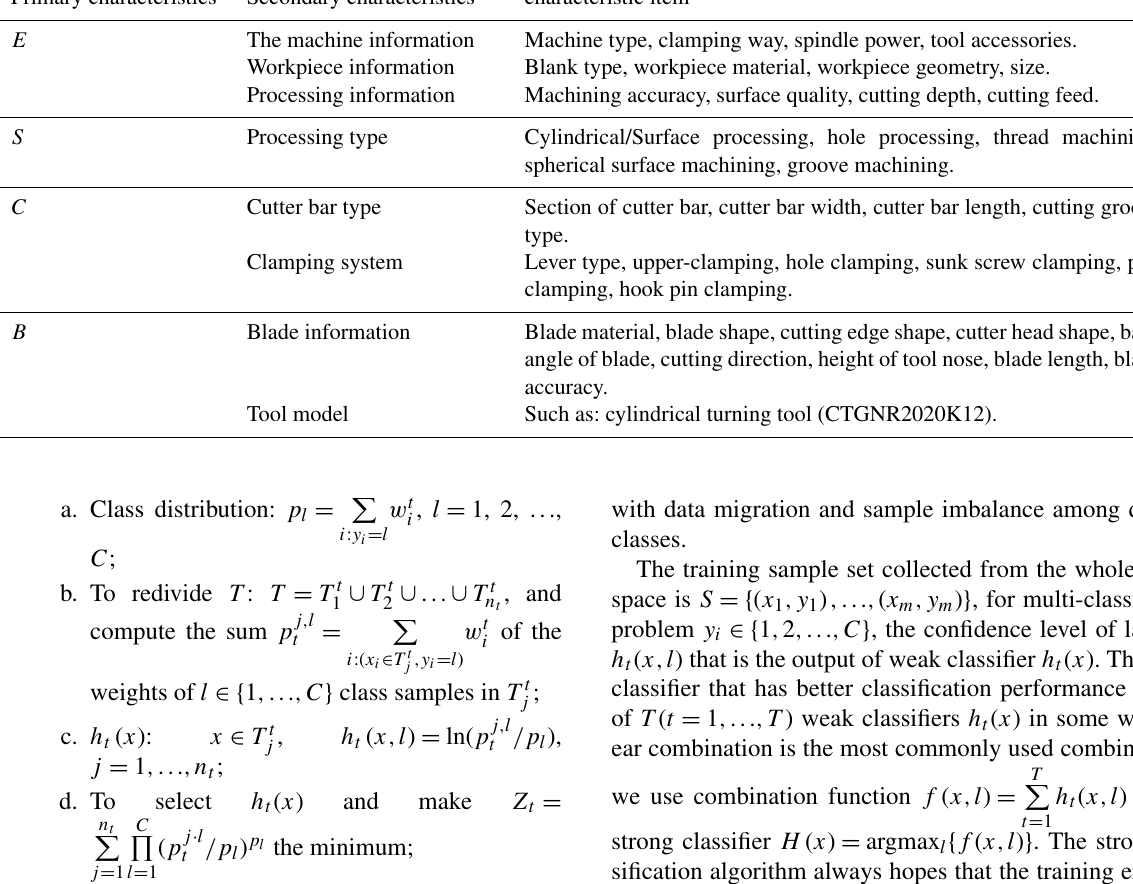
Table 1. The characteristic items contained in expert experience (CNC turning tool). Primary